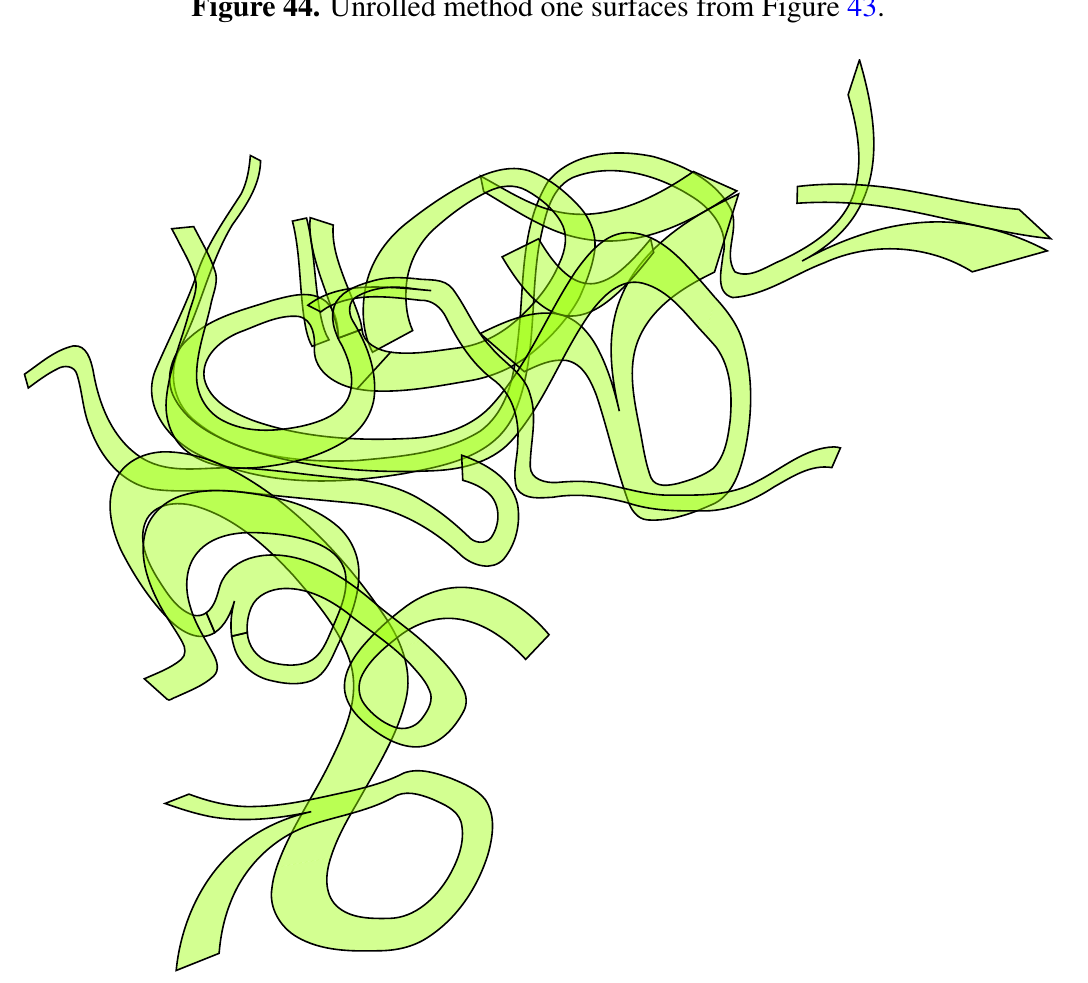
Figure 44. Unrolled method one surfaces from Figure